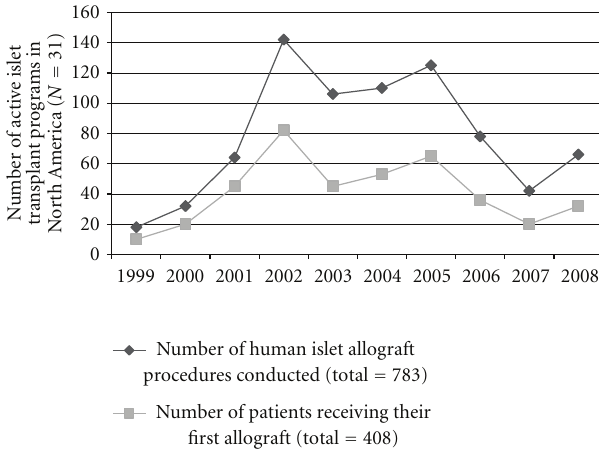
Figure 1: Total number of islet transplant recipients and total in- fusions in North America, 1999–2008, based on the CITR 2009 An- nual Report [45].